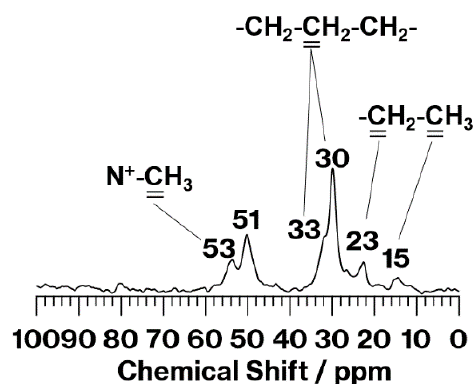
Figure 3. 13 C CP MAS NMR spectrum of C18TAC/MeO-Kaol_Wash.